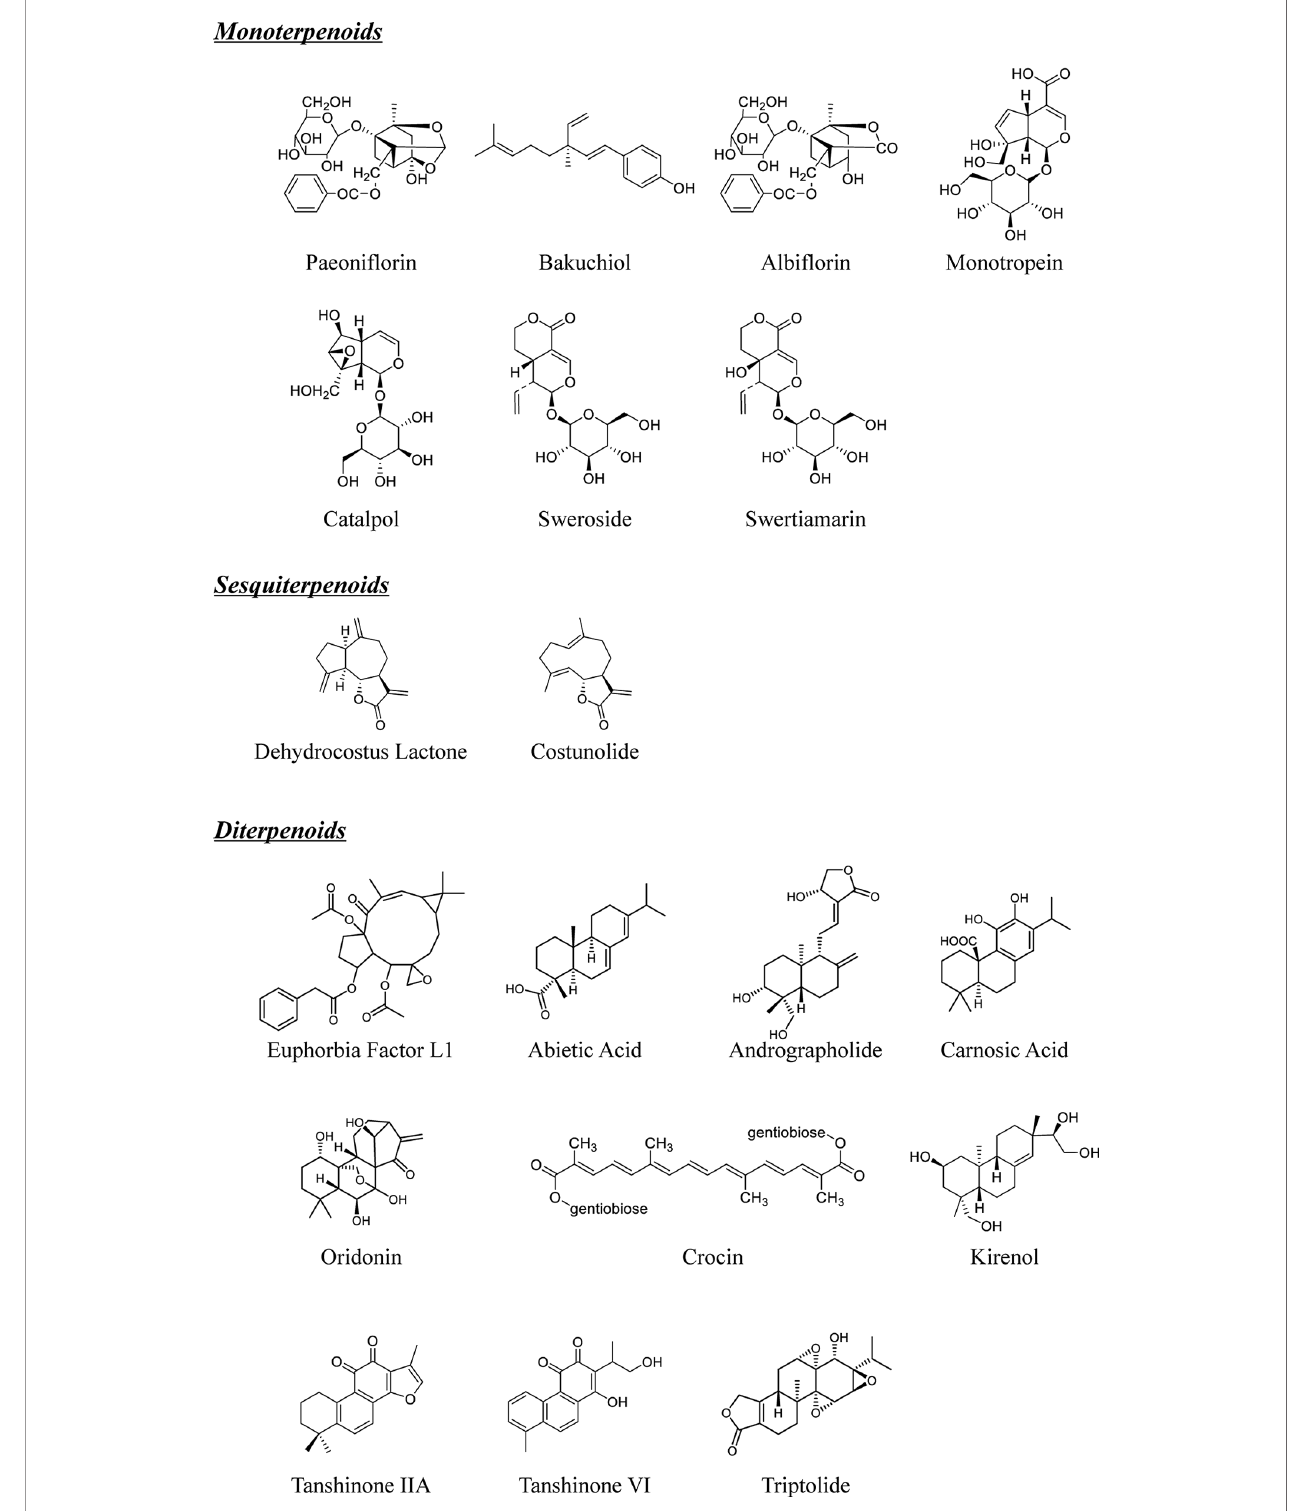
FIGURE 1 | Chemical structures of natural monoterpenoids, sesquiterpenoids and diterpenoids from TCM.